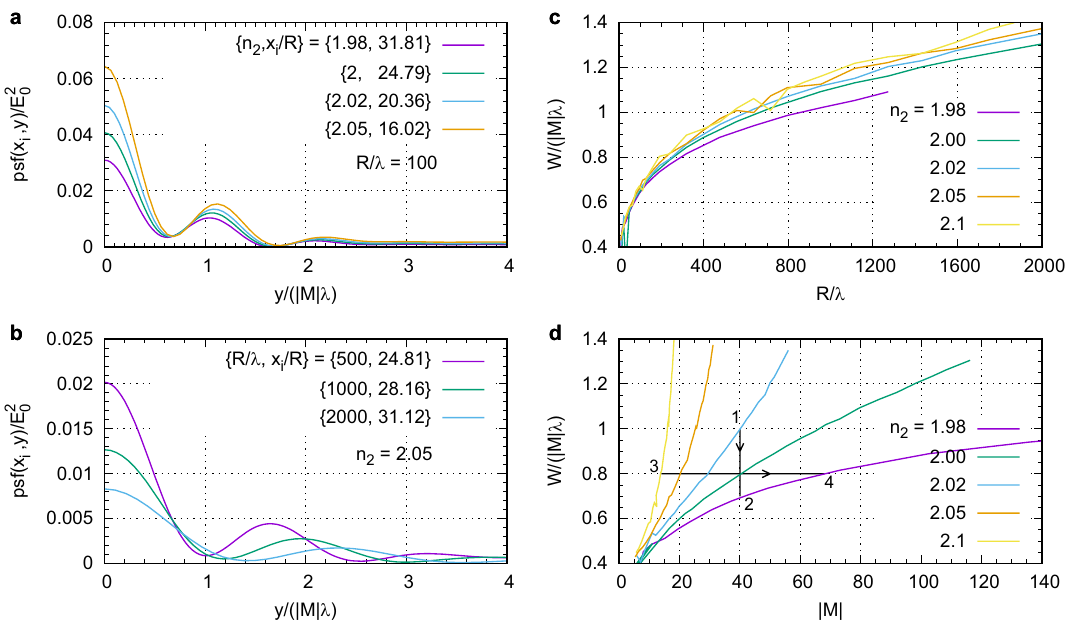
Figure 6. Resolution of ball lens imaging. ( a ) psf ( x i , y ) as a function of the transverse coordinate y at the positions x i of the diffraction focus for several values of n 2 and fixed R / (cid:31) . ( b ) same as ( a ) but for several values of R / (cid:31) and fixed n 2 . ( c ) Resolution W /( (cid:31) ) as a function of magnification W /( M | |